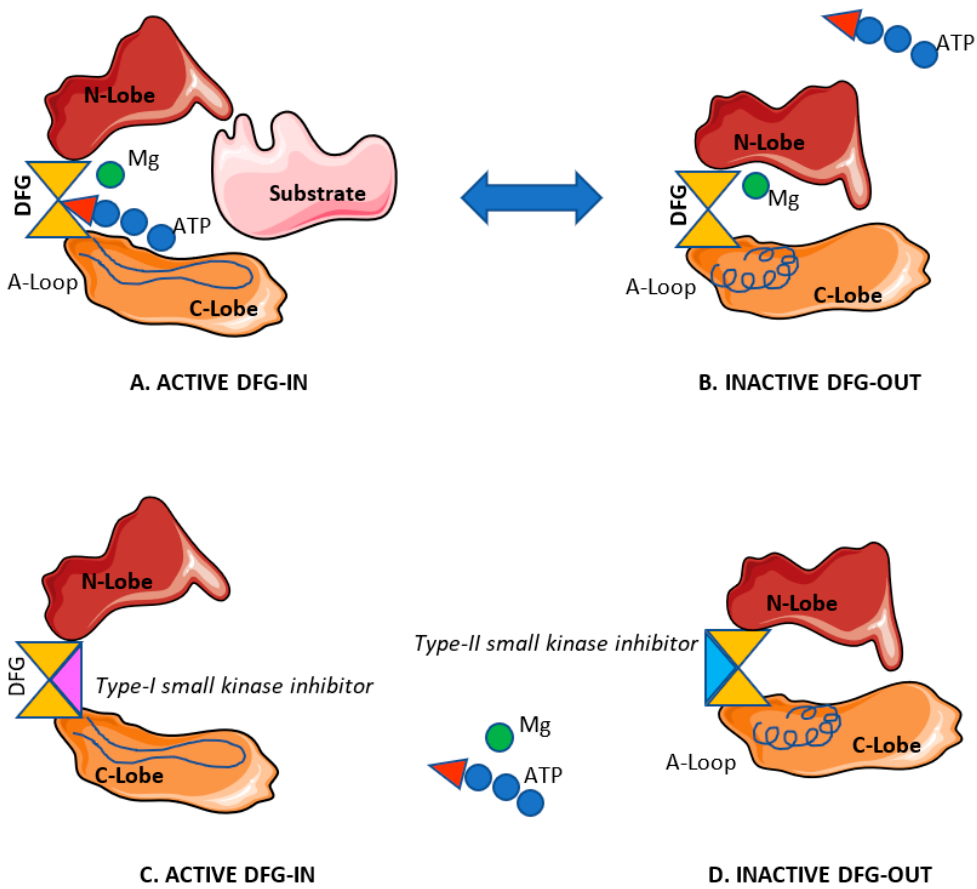
Figure 1. Active and inactive structural fold of model protein kinase. Conformational changes in the catalytic domain is required for kinase function. ( A ) Active protein kinase (open) and substrate molecule. ( B ) Inactive protein kinase (closed) with folded activation loop. ( C ) Type-I small kinase inhibitor competes for the primary ATP-binding domain of kinase active conformation. ( D ) Type-II inhibitors bind to an allosteric pocket adjacent to the ATP-binding site in the inactive state impeding kinase activation. Abbreviations: N-Lobe: N-Terminal subdomain. C-Lobe: C-Terminal subdomain. DFG: (Asp-Phe-Gly)-Motif. Mg: Magnesium. ATP: Adenosine Triphosphate